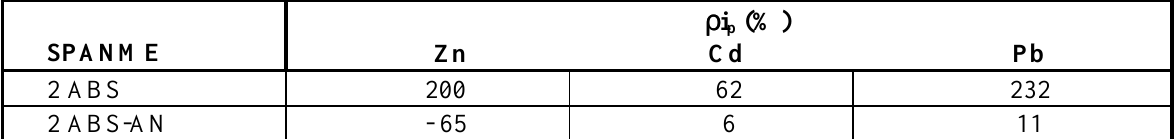
Table 1. Percentage change in the peak current of 10 -7 mol L -1 Cd 2+ , Pb 2+ , Zn 2+ at SPANME.